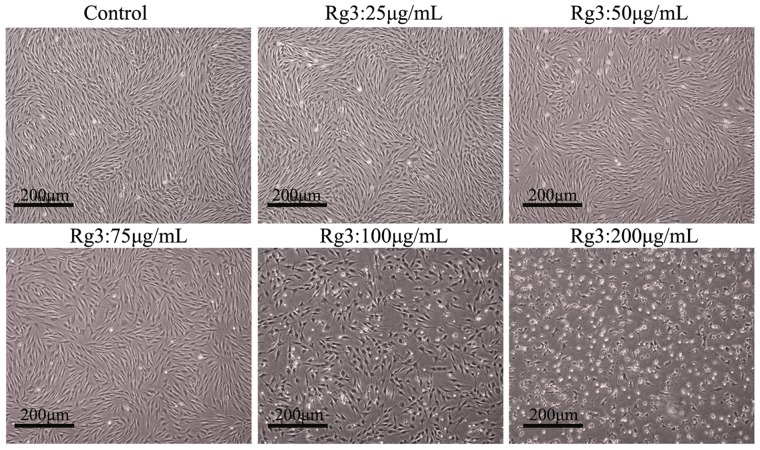
Morphology of HSFs treated with different concentrations of Rg3.Adherent HSFs were untreated or treated with 25, 50, 75, 100, 200 µg/mL Rg3 for 48 h. Images were taken using a light microscope and a digital camera. Original magnification: 40×.